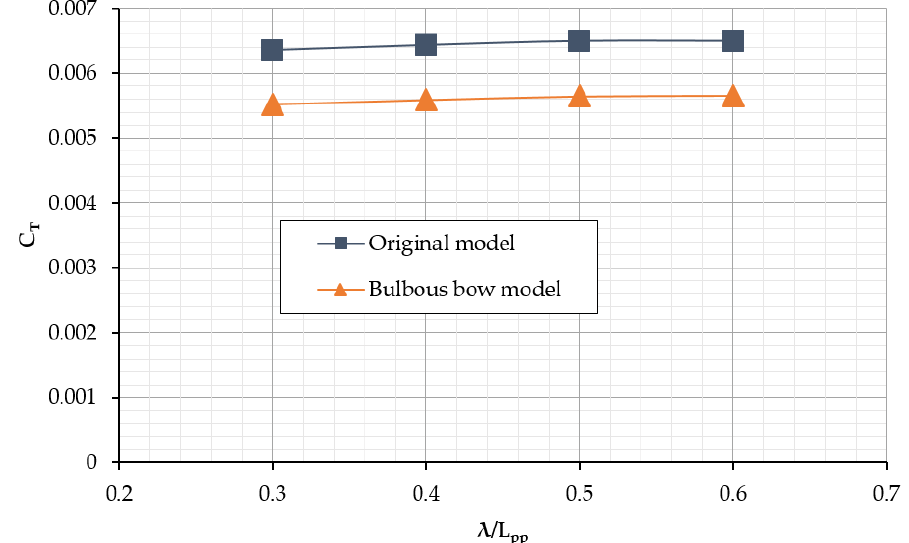
Figure 13. Total ship resistance coefficients under the condition of regular head waves, H w = 0.02 m at F n = 0.163. Table 6. Computed ship resistance of the original model under wave conditions.